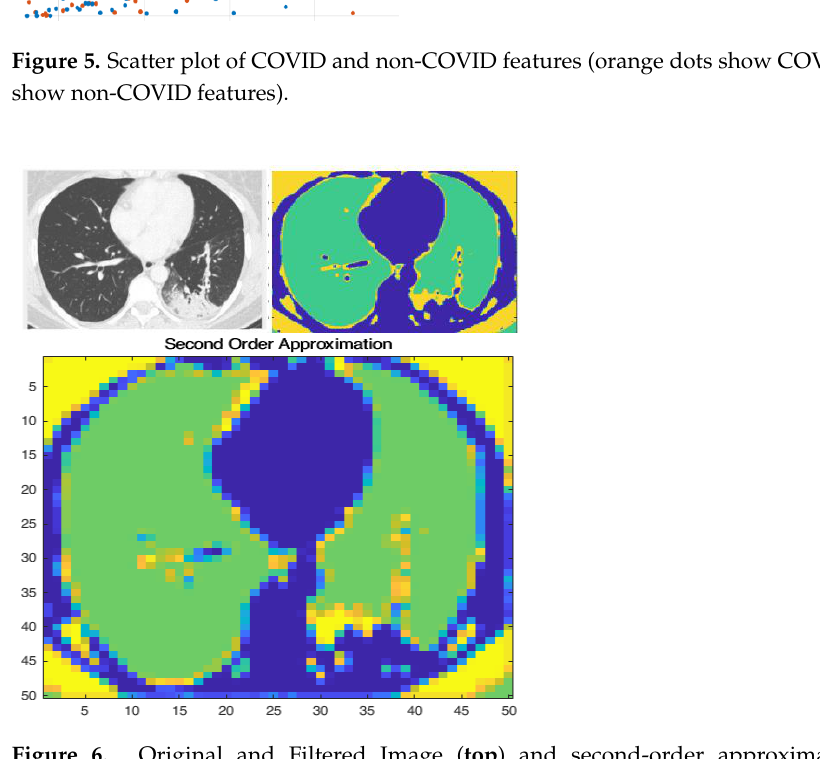
Figure 5. Scatter plot of COVID and non-COVID features (orange dots show COVID and blue dots show non-COVID features).